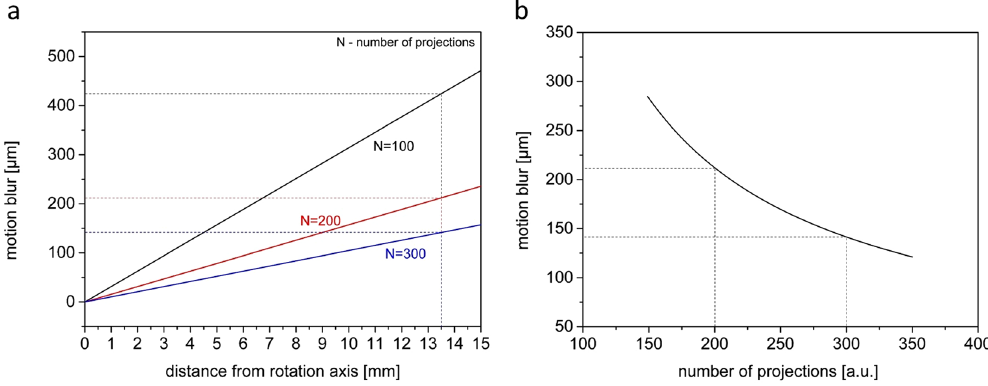
Figure 3. Continuous sample rotation results in motion blur of radiographic projections. Motion blur increases linearly with distance from rotation axis ( a ) and is inversely proportional to the number of projections ( b